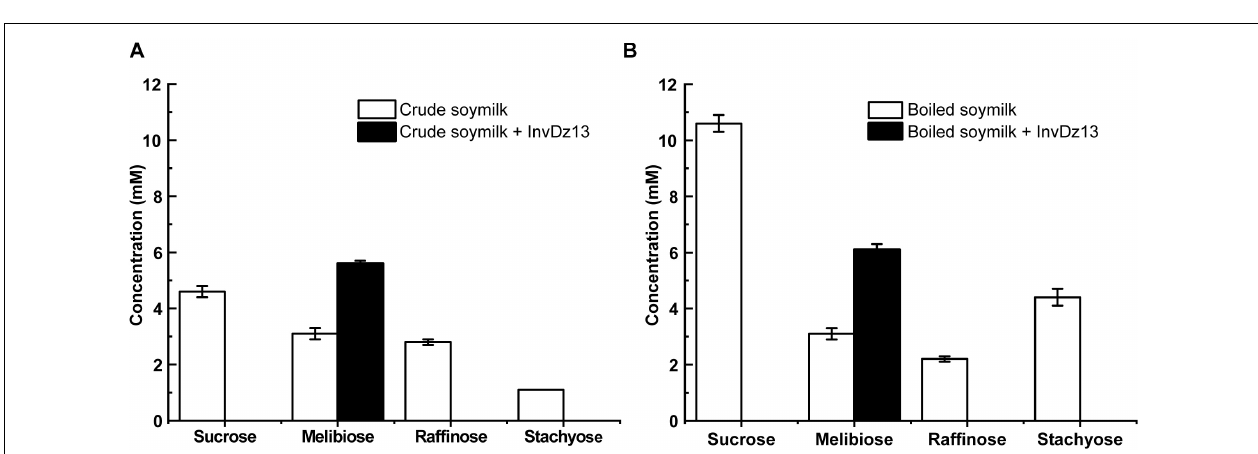
FIGURE 3 | Bioconversion of sucrose, raffinose, or stachyose through InvDz13 hydrolysis. Reaction supernatants were collected after 10 min reaction and used to determine mono-, di-, and tri-saccharides released from sucrose, raffinose, or stachyose after adding InvDz13. Saccharides were determined using HPLC at 30 ◦ C by using a TSKgel Amide-80 column and an evaporative light-scattering detector 2424.